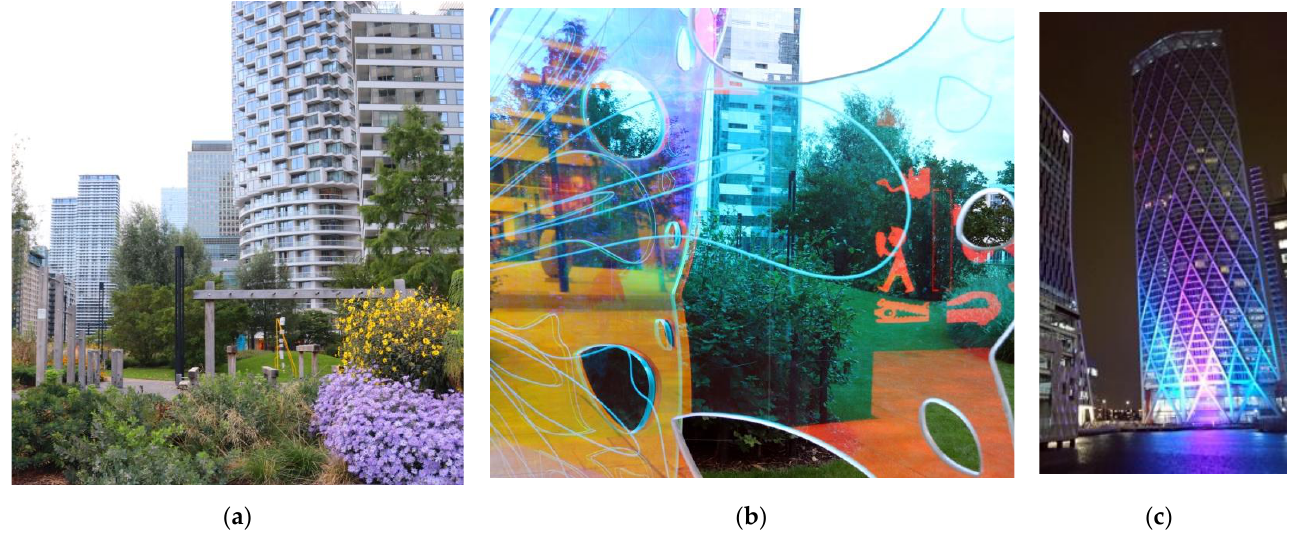
Figure 22. Colours and visual connections at the human scale; ( a ) Soft landscaping in the new park on Wood Wharf (2021); ( b ) Public art on Wood Wharf provides opportunities to experience colourful surroundings (2021); ( c ) Night time colourful illumination of the Newfoundland building (2021).